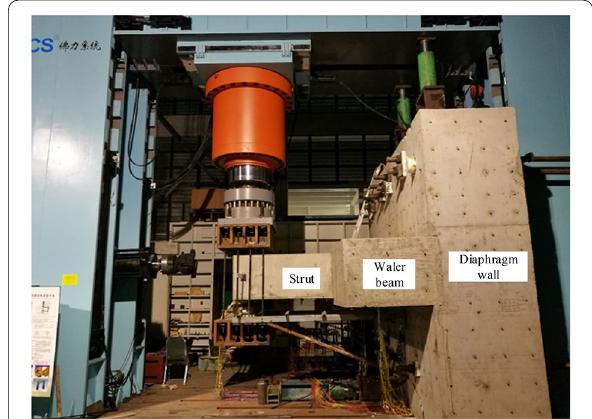
Fig. 4 Configuration of a wall–beam–strut joint.